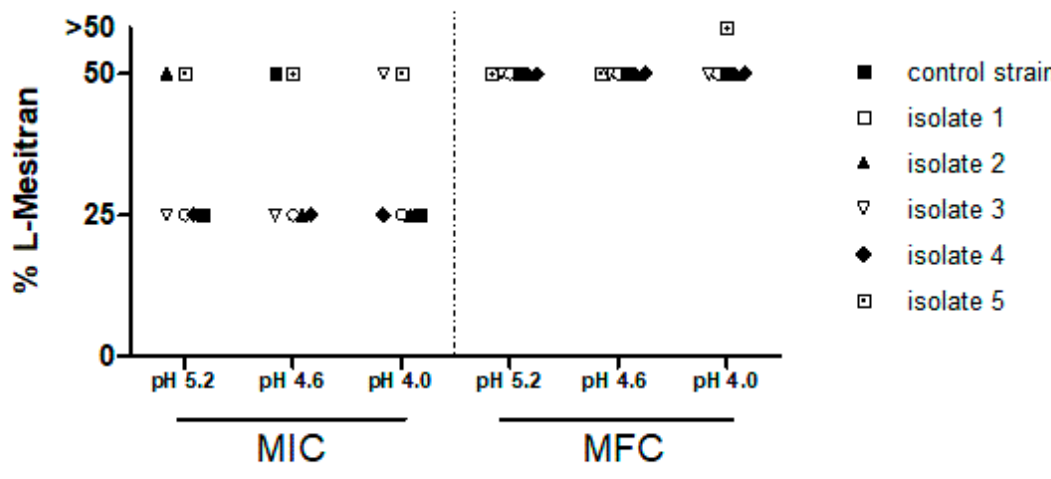
Figure 1. Activity of L-Mesitran against clinical Candida albicans isolates tested at pH 5.2, 4.6, and 4.0, shown as the minimum inhibitory concentrations (MIC) and minimum fungicidal concentrations (MFC). NCPF 3179 was added as the control strain.